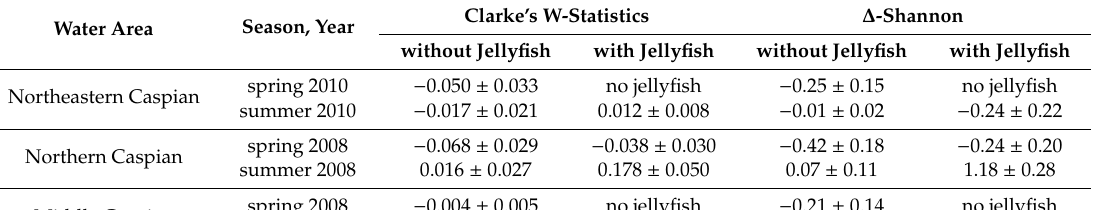
Table 6. Values of Clarke’s W-statistics of and ∆ -Shannon for zooplankton communities in the surveyed water area of the Caspian Sea (mean with standard error).